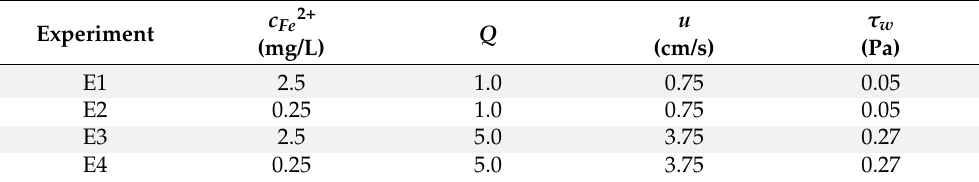
Table 1. Overview of the conducted